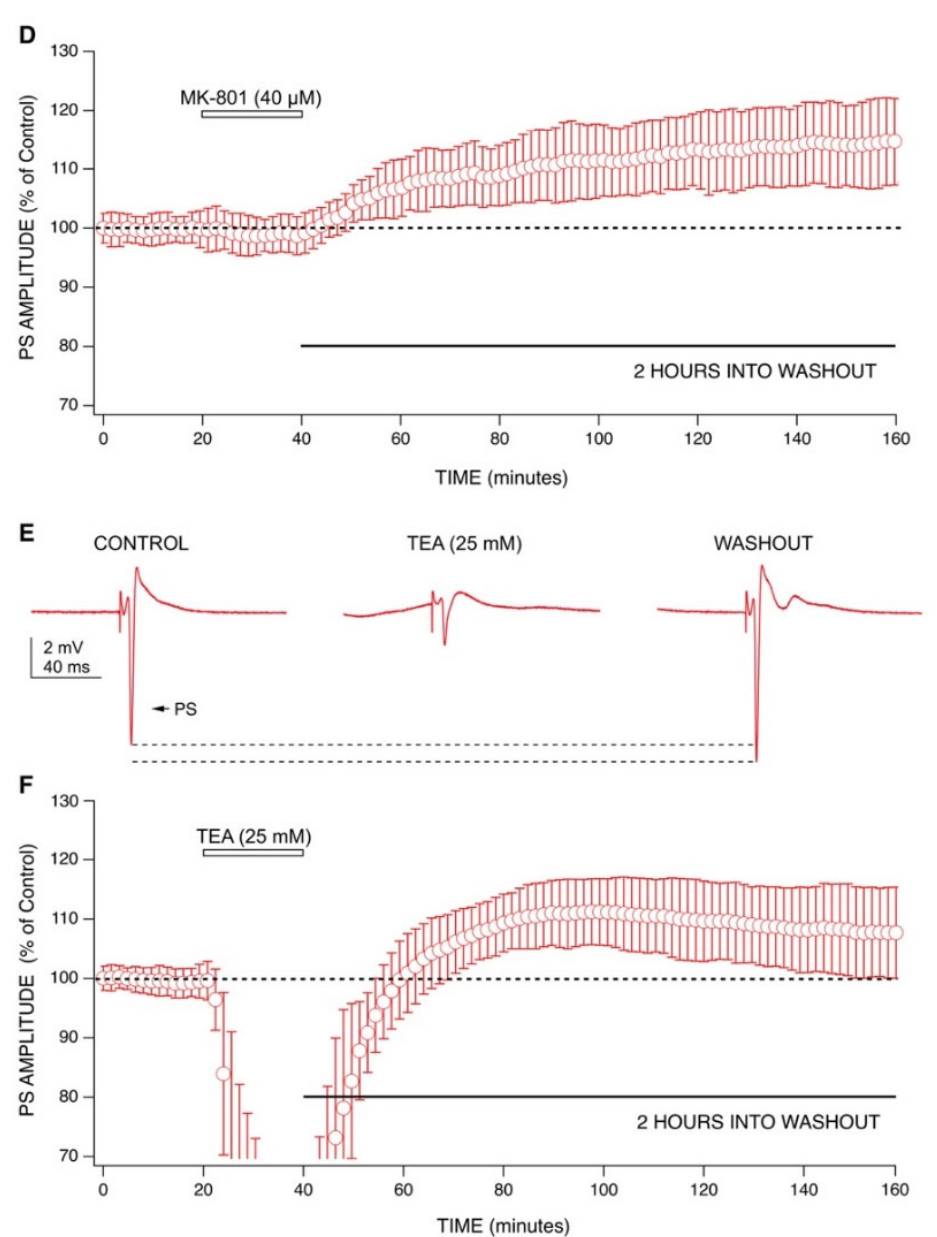
Figure 4. The effects of APV, MK-801, and TEA on population spike amplitudes. ( A ) Representative recordings from one APV experiment (100 µ M) showing changes in PS amplitudes during applica- tion and washout. ( B ) Combined graph ( n = 10) shows 100 µ M APV produced a small depression in PS amplitudes during application. PS amplitudes increased during washout of APV, lasting approximately 40 min before decreasing back to baseline by 150 min (110 min into washout). ( C ) Rep- resentative recordings from one MK-801 experiment (40 µ M) showing changes in PS amplitudes during application and washout. ( D ) Combined graph ( n = 7) shows 40 µ M MK-801 produced a small decrease in PS amplitudes during application. Washout of MK-801 produced a sustained increase in PS amplitudes for two hours. ( E ) Representative recordings from one TEA experiment (25 mM) showing changes in PS amplitudes during application and washout. ( F ) Combined graph ( n = 9) shows 25 mM TEA produced a large depression in PS amplitudes during application. Washout of TEA produced an increase in PS amplitudes that was sustained for two hours. Data points from each combined graph represent the mean ± standard deviation derived from a data set of several averaged experiments decimated from approximately 480 to 100 data